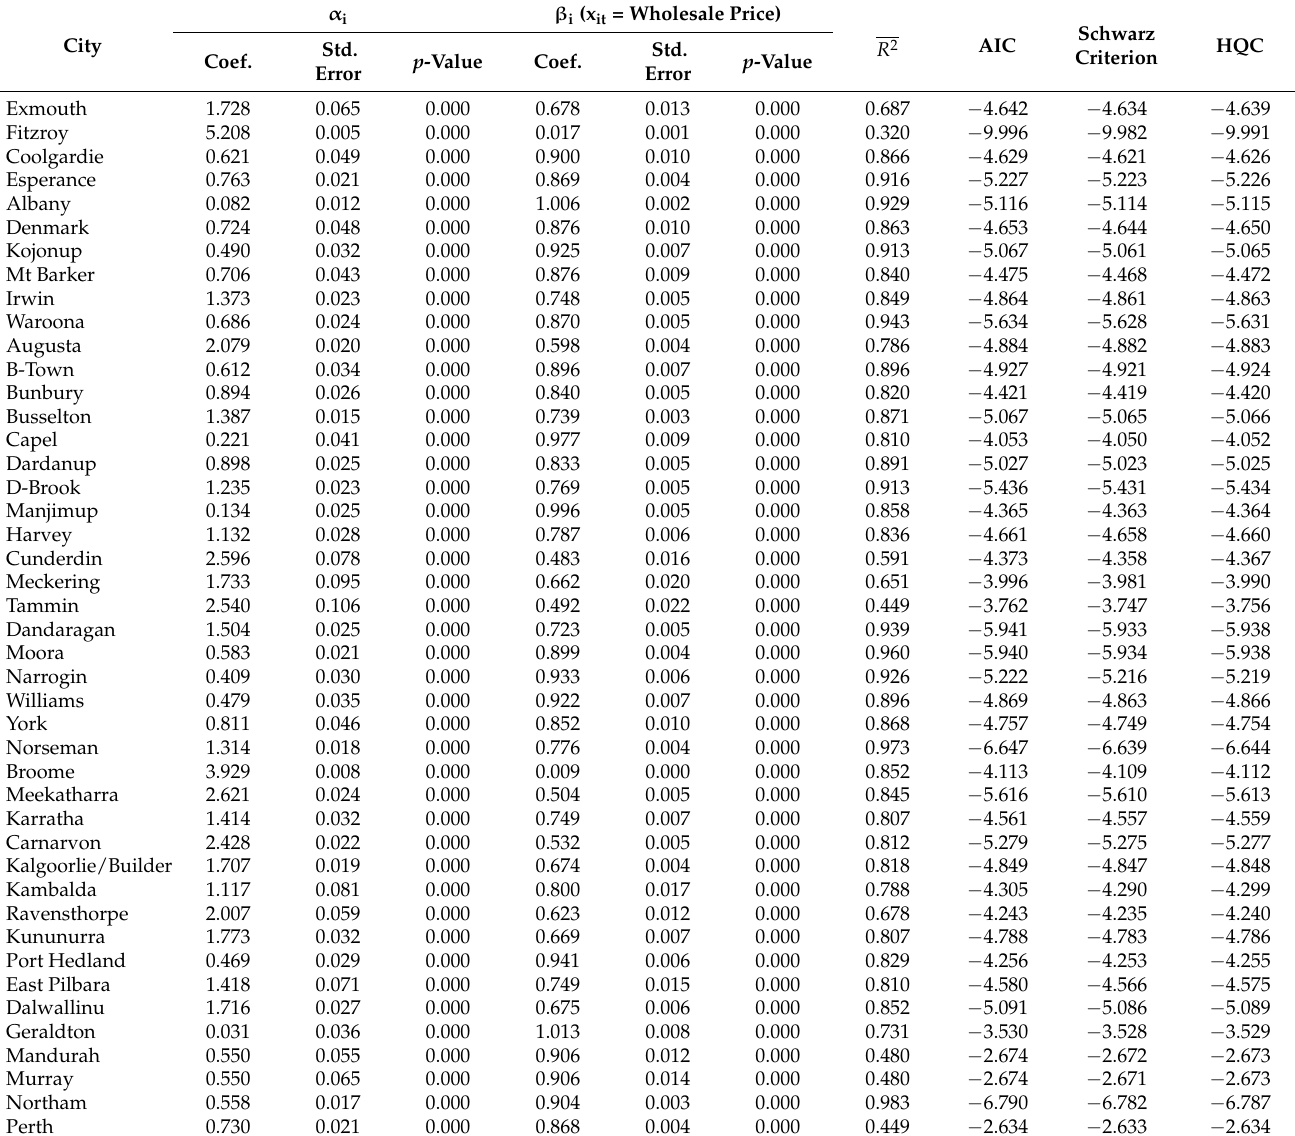
Table 6. The relationship between the retail petrol price and wholesale petrol price. Model A: logp it = α i + β i logx it + ε it